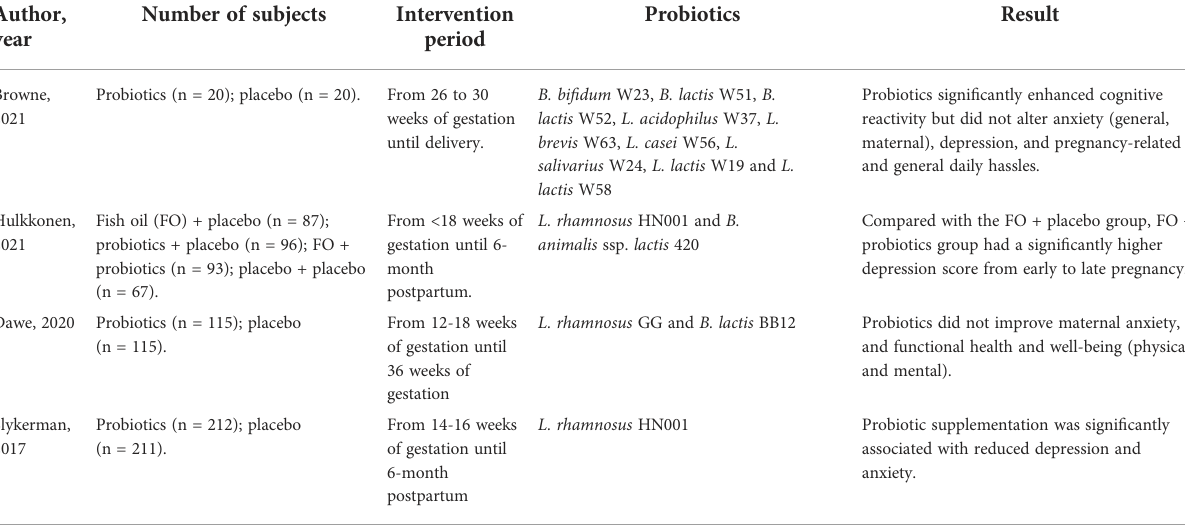
TABLE 3 Characteristics of studies evaluating the role of probiotics in perinatal depression.